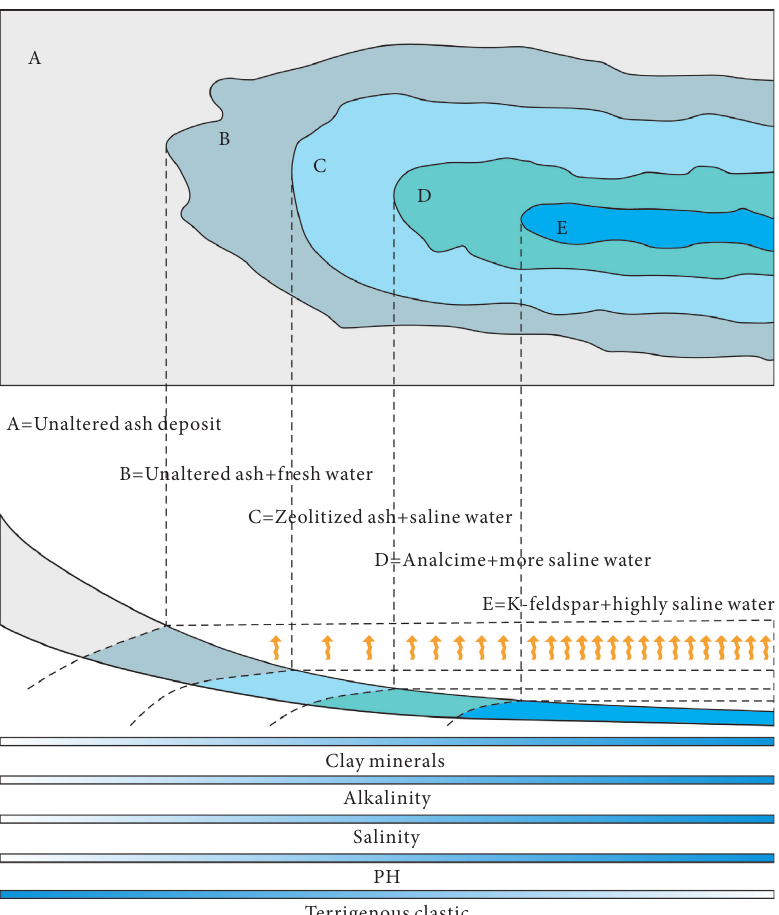
Figure 6: Distribution of authigenic mineral zones in the saline, alkaline playa-lake system (modified according to Langella et al., 2001).